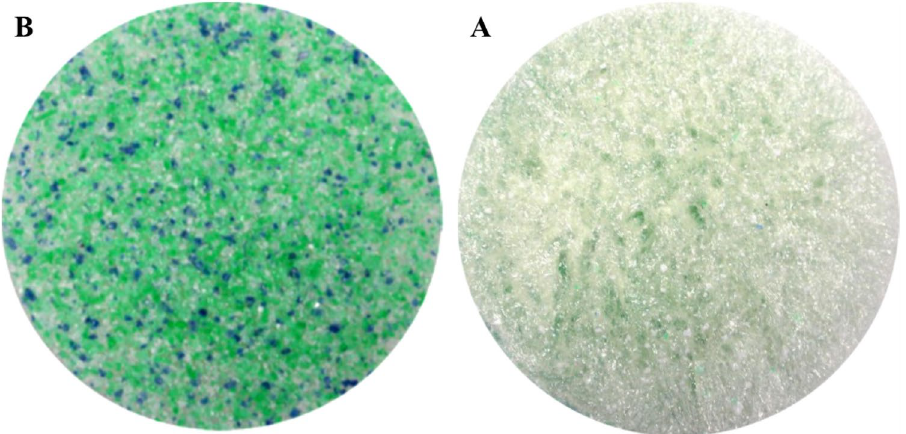
Figure 4. Images of sample 13, showing PET flakes at the bottom (left side, B ) and PET and/or PS powders at the top of the sample (right side, A ).